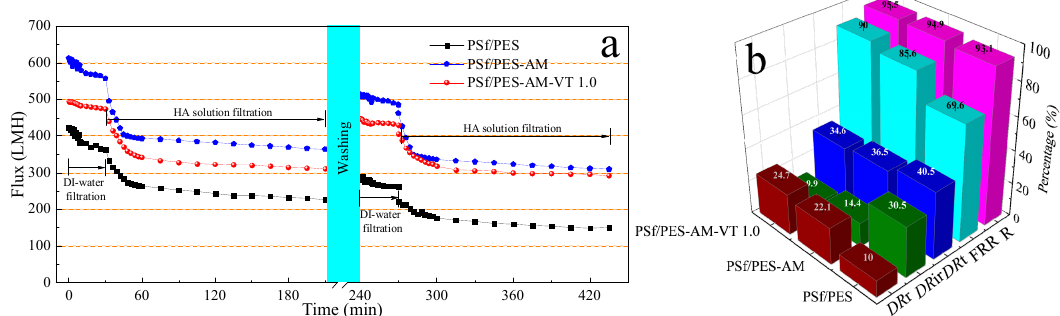
Figure 12. ( a ) Time-dependent flux in two cycles of the resulting membranes in the 5 mg · L − 1 HA solution filtration process. ( b ) Corresponding reversible flux decline ratio ( DR r ), irreversible flux decline ratio ( DR ir ), total flux decline ratio ( DR t ), flux recovery ratio ( FRR ), and HA rejection ( R ).